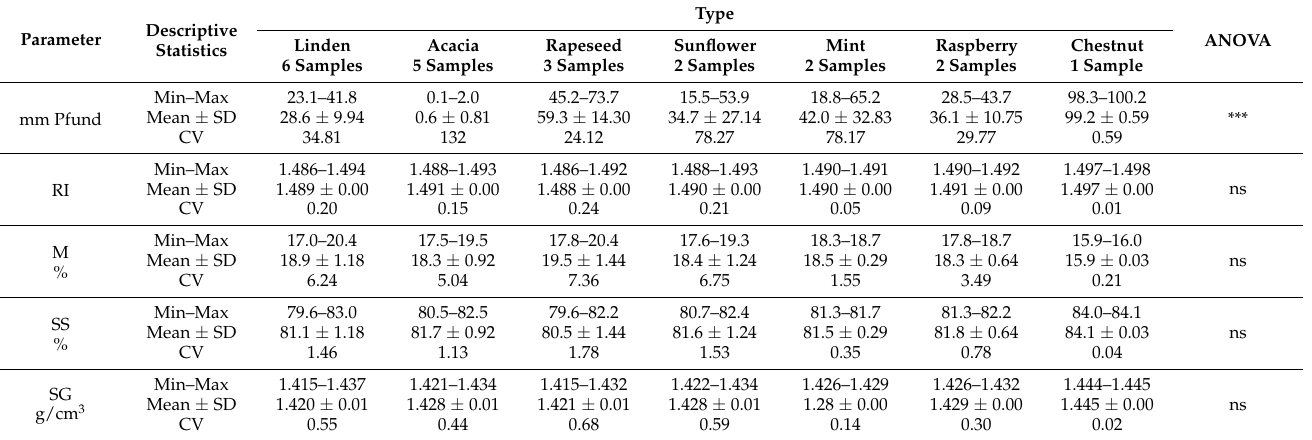
Table 2. Parameter values (mm Pfund, refractive index, moisture, solid substances’ content, and specific gravity) of seven types of honey.